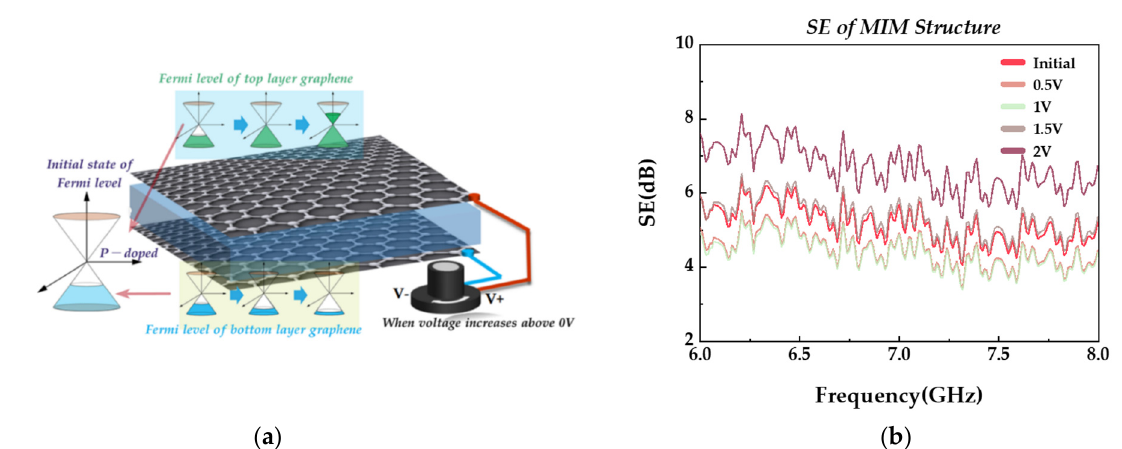
Figure 5. ( a ) The Fermi level of graphene under bias voltage; ( b ) SE curves of MIM structure when voltage increases from initial.